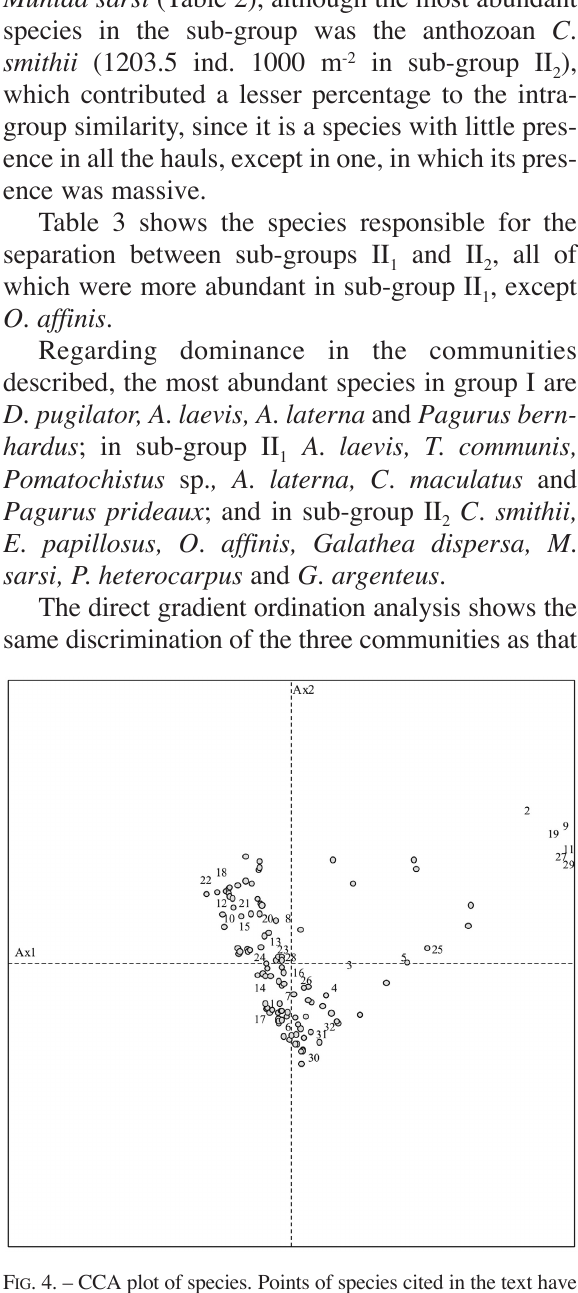
(%): percentage of dissimilarity i (%): cumulative δ i